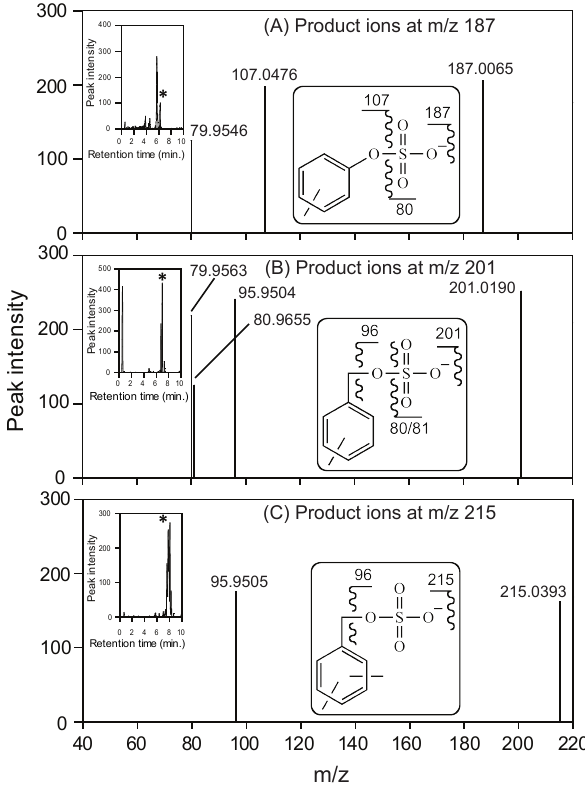
Fig. 3. Tandem mass spectra of aromatic organosulfates with par- ent m / z of 187 (A) , 201 (B) and 215 (C) in PM 2 . 5 , Lahore, Pak- istan. Chromatographic peaks marked with star were used in gen- erating the product ion mass spectra. Proposed structures are based on molecular formulas and fragment